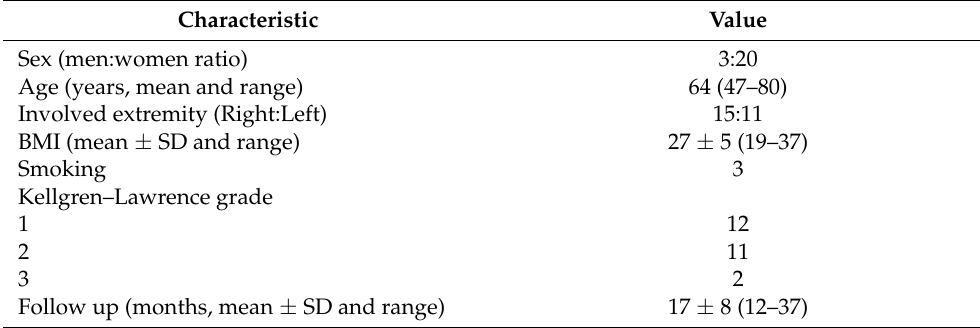
Table 1. Demographic data of patients. Characteristic